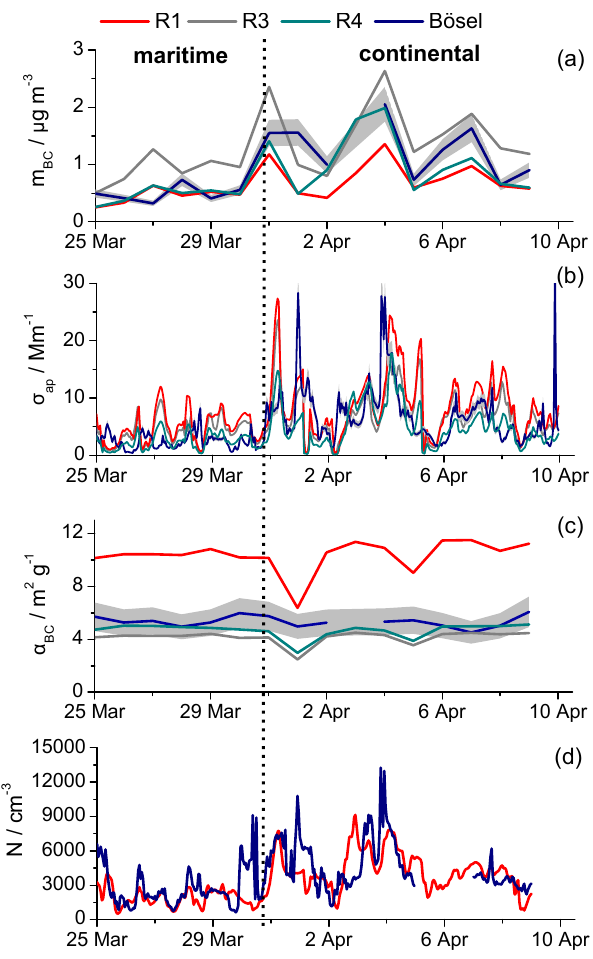
Figure 3. Comparison between measured C soot and modelled BC mass concentrations (m BC ) (a) , absorption coefficient ( σ ap ) (b) , mass absorption cross-sections ( α BC ) (c) and particle number con- centration ( N ) (d) at the regional observation site Bösel. Besides the results for model base run R1, the time series from additional model runs R3 and R4 are also shown, which differ from R1 in the EC emissions and the calculation of optical properties (see Table